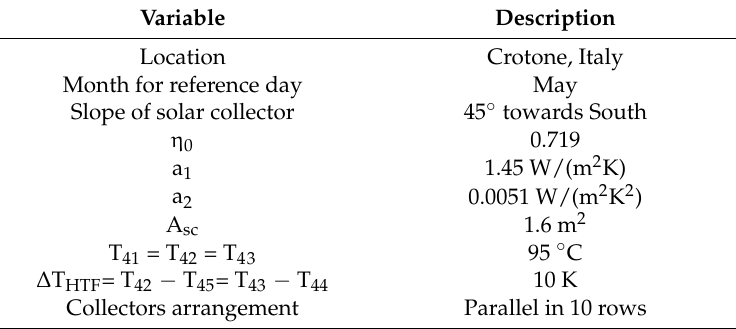
Table 3. Solar-thermal collector fields operating